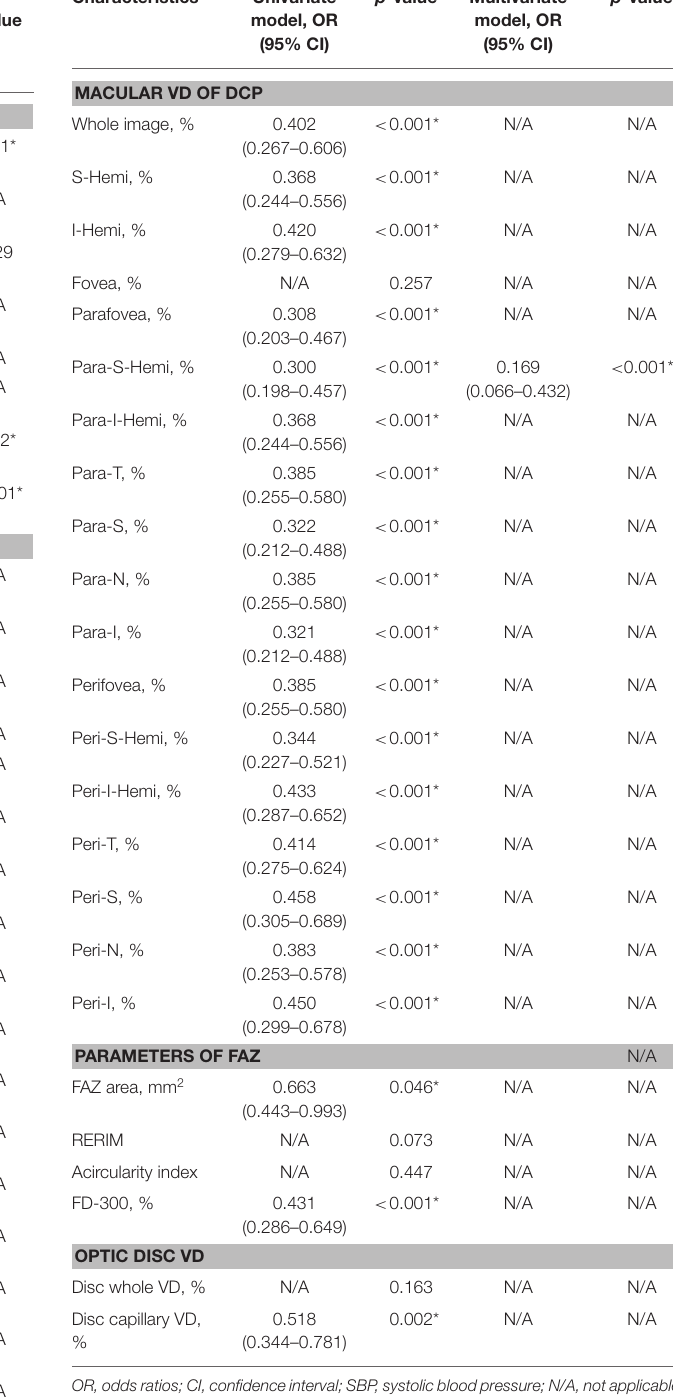
TABLE 3 | Risk factors for stroke using binary logistic regression analysis ( n =